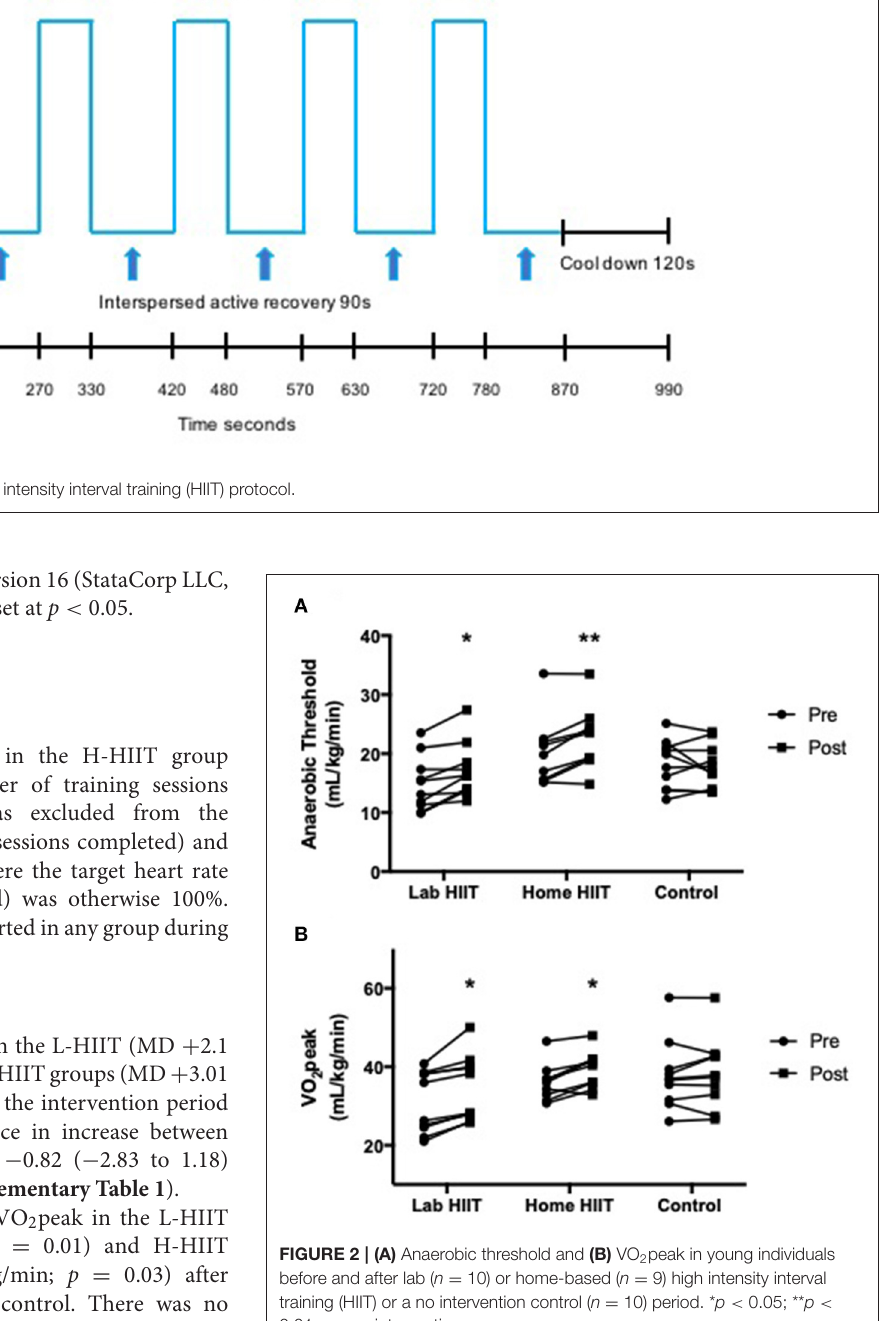
FIGURE 2 | (A) Anaerobic threshold and (B) VO 2 peak in young individuals before and after lab ( n = 10) or home-based ( n = 9) high intensity